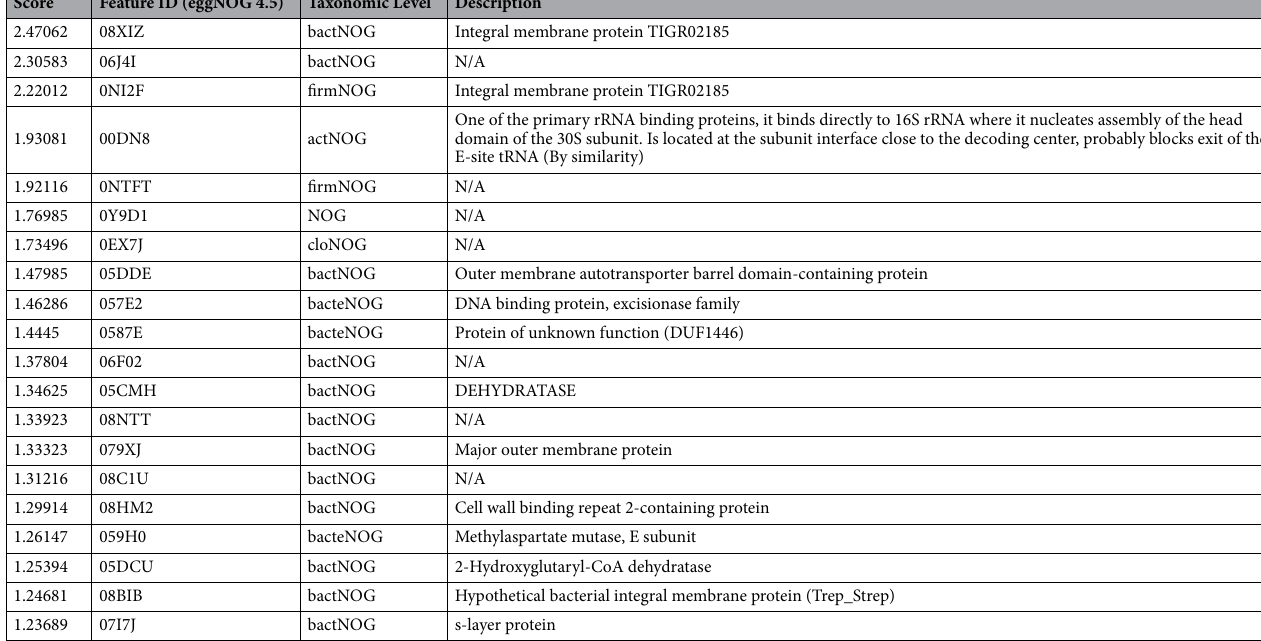
Table 5. The 20 most relevant eggnog features selected by the